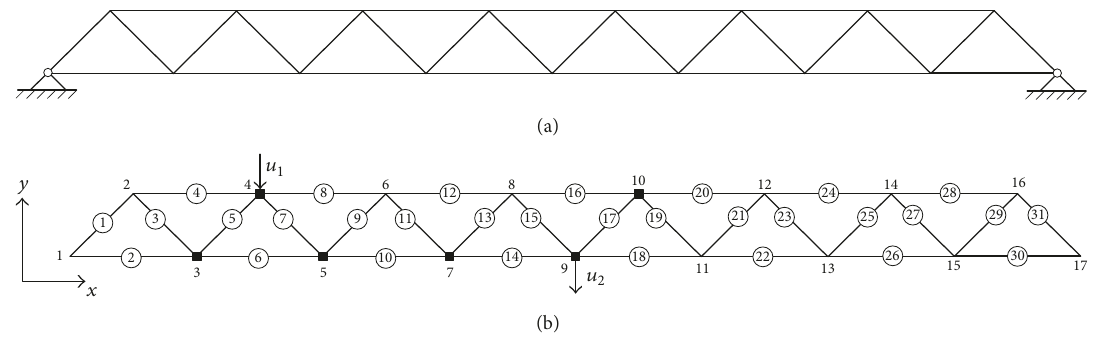
Figure 1: (a) Truss structure. (b) Finite element model of the truss and the sensor placement.